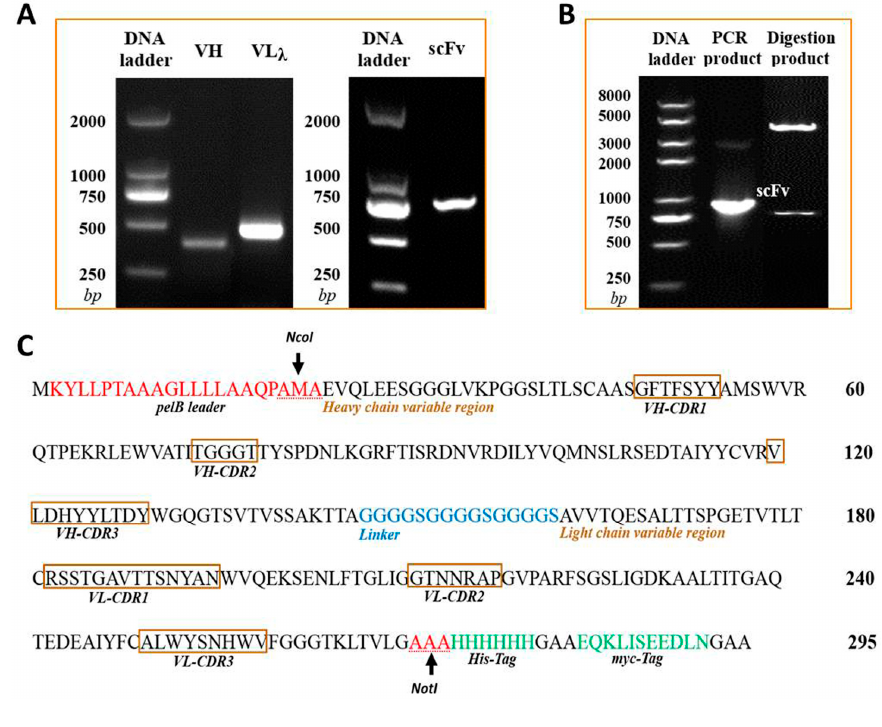
Figure 1. Construction and confirmation of the anti-triazophos scFv-8C10 expression vector. ( A ) The VH and VL λ fragments of anti-triazophos mAb-8C10 gene were amplified and assembled into the scFv-8C10 fragment via SOE-PCR (overlap extension polymerase chain reaction); ( B ) the recombinant expression vector PIT2-scFv-8C10 was confirmed via PCR and restriction enzyme digestion; and ( C ) deduced amino acid sequences of scFv-8C10 expressed in E. coli ( Escherichia coli ) HB2151 were according to the nucleotide sequences.